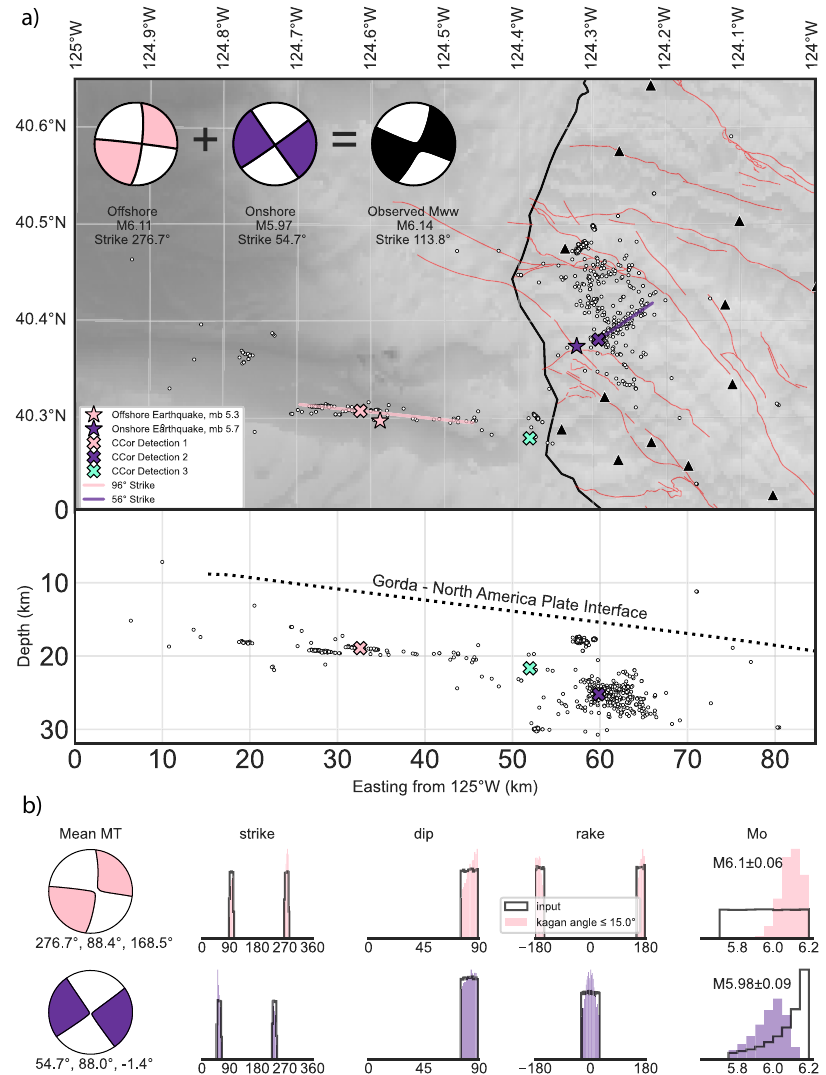
Fig. 1 High precision earthquake locations and inferred decomposed moment tensors. a Relocated seismicity (small circles) showing the two distinct clusters of seismicity in this seismic sequence. The pink star and x show the absolute location and location of the best matching aftershock of the offshore rupture, respectively. The purple star and x show the same for the onshore rupture. In the top left corner, the inferred moment tensors from decomposing the observed Mww combined moment tensor are shown. Relocated seismicity along an east-west cross section is shown below the map. Seismic stations used in relocations are shown as black triangles. The dashed line shows the plate interface between the Gorda and North American Plates 34 . b Results from Monte Carlo approach to determine two moment tensors whose combination can reproduce the observed Mww, given geometric constraints from earthquake relocations (see “ Methods ”